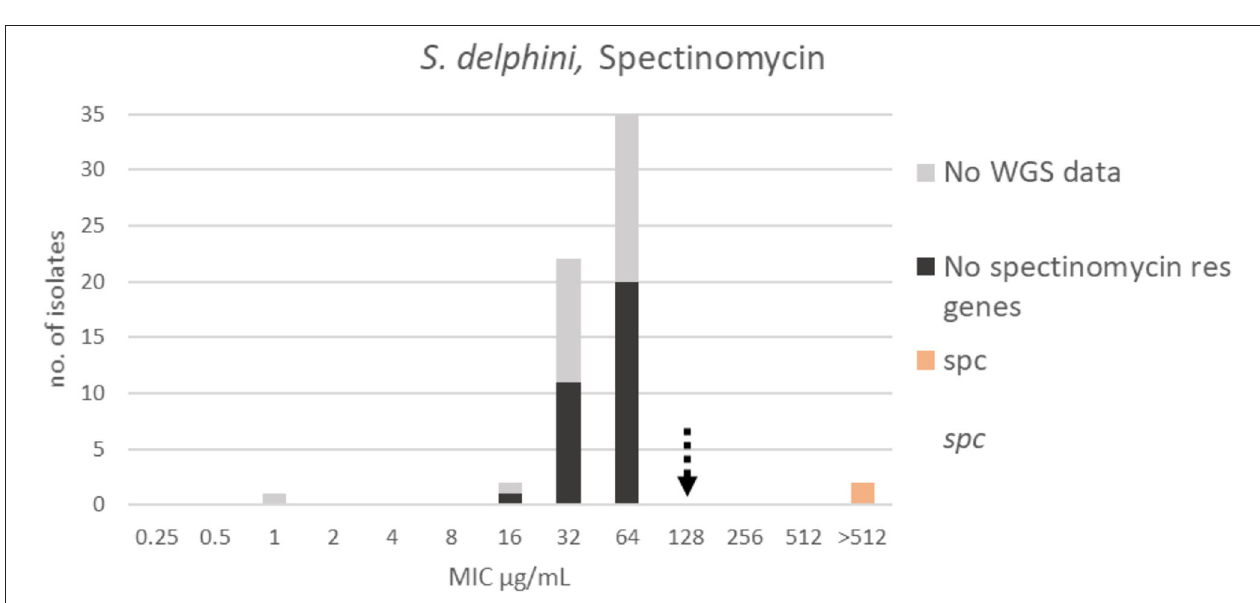
Streptococcus canis The MIC distributions of S. canis are presented in Supplementary Figure 1 . Tentative ECOFFs were suggested for five of the seven antimicrobials tested ( Table 4 ). With the exception of SXT, a high number of isolates were found in the non-wildtype populations ( Table 6